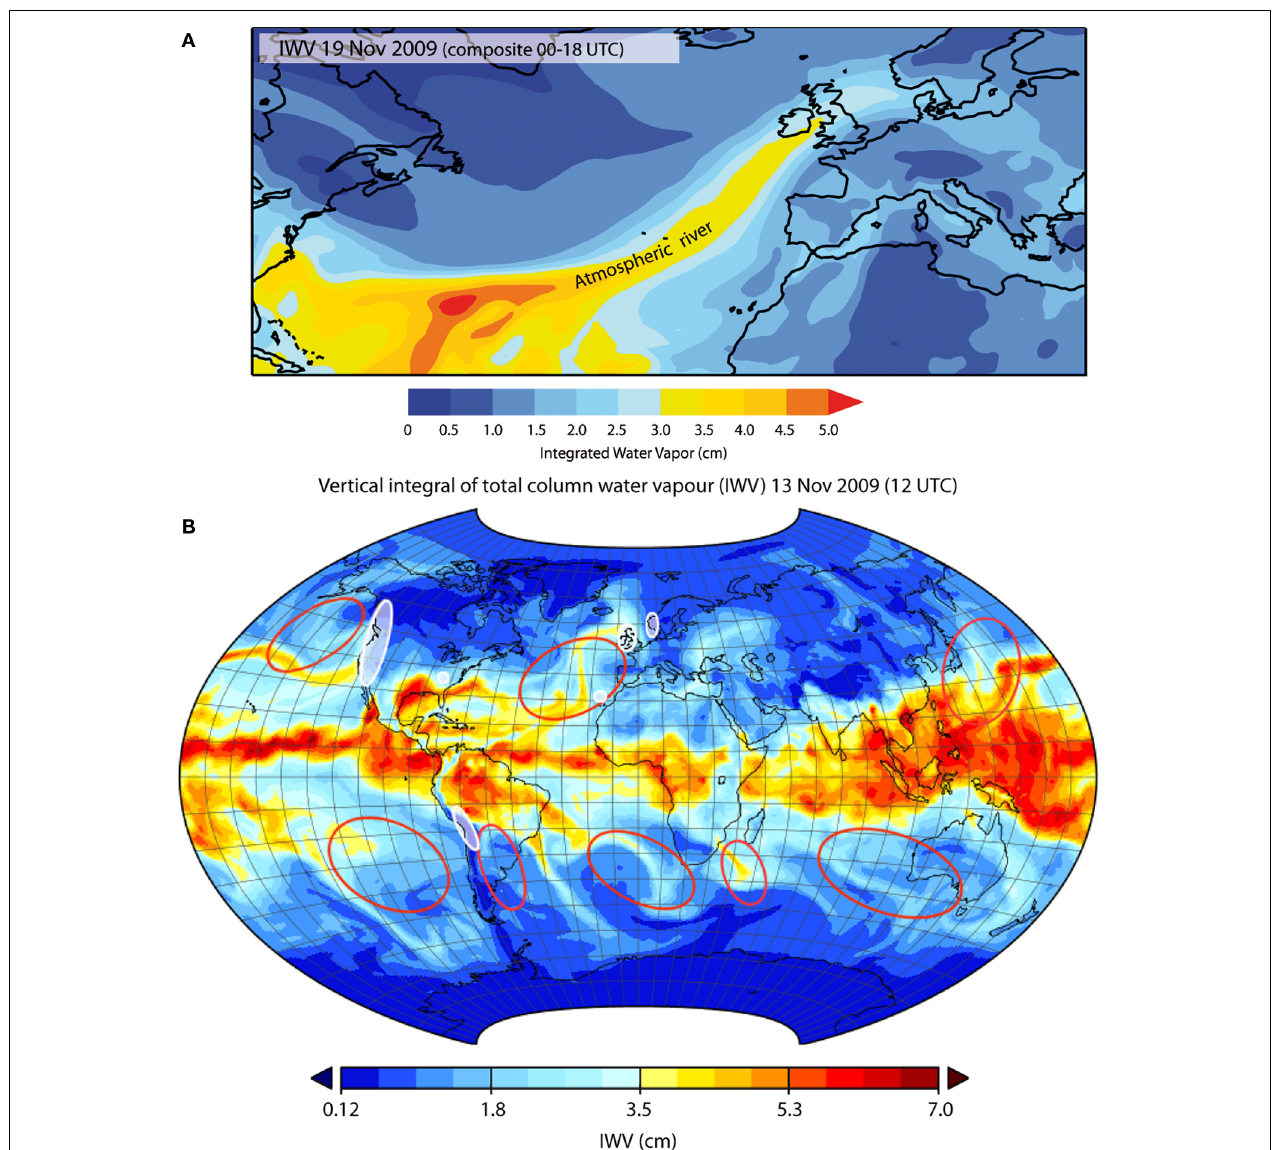
FIGURE 1 | (A) Composite Integrated Total Column of Water Vapor (IWV) between 00 and 18 UTC 19 November 2009 showing an atmospheric river (AR) associated with extreme precipitation events that affected the United Kingdom (UK). Data: ERA-Interim. (B) A general distribution of areas of